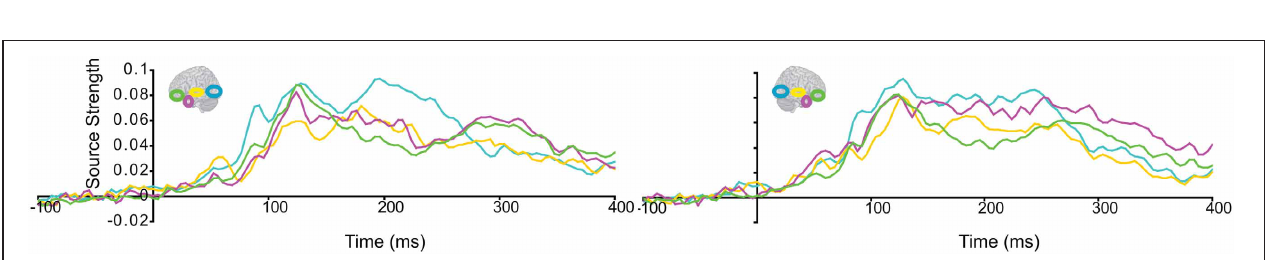
FIGURE 7 | Regional response waveforms to intact audio-visual object trials, averaged across participants.